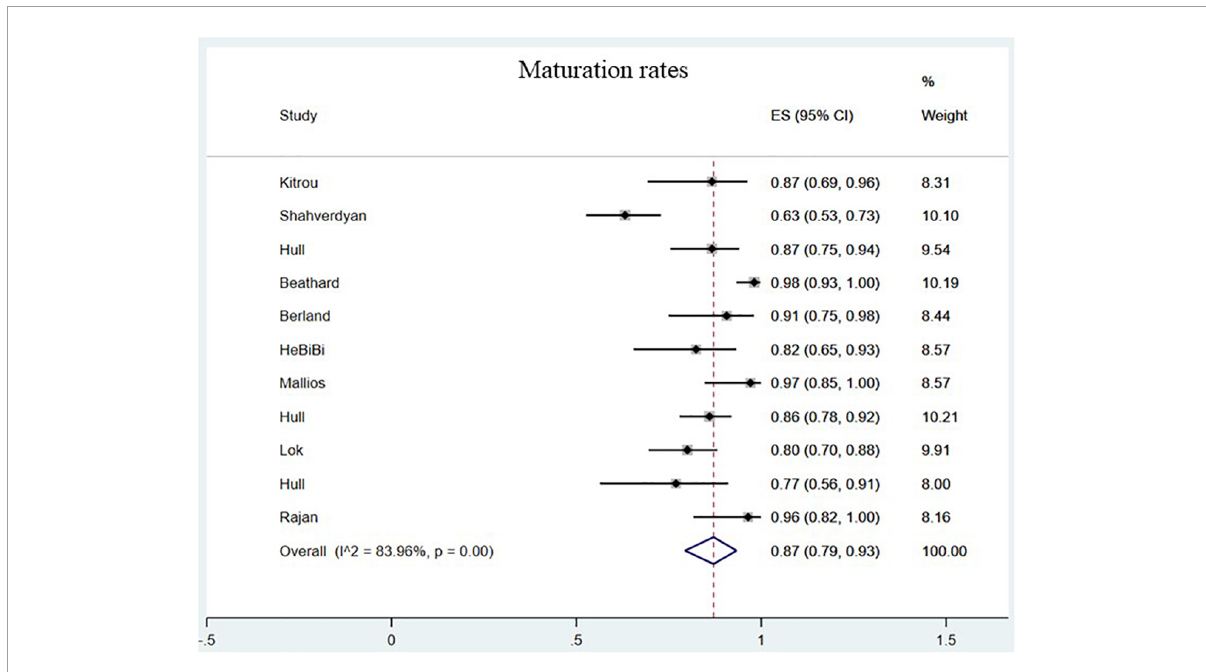
FIGURE4 Pooled maturation rates. CI, confidence interval; ES, effect